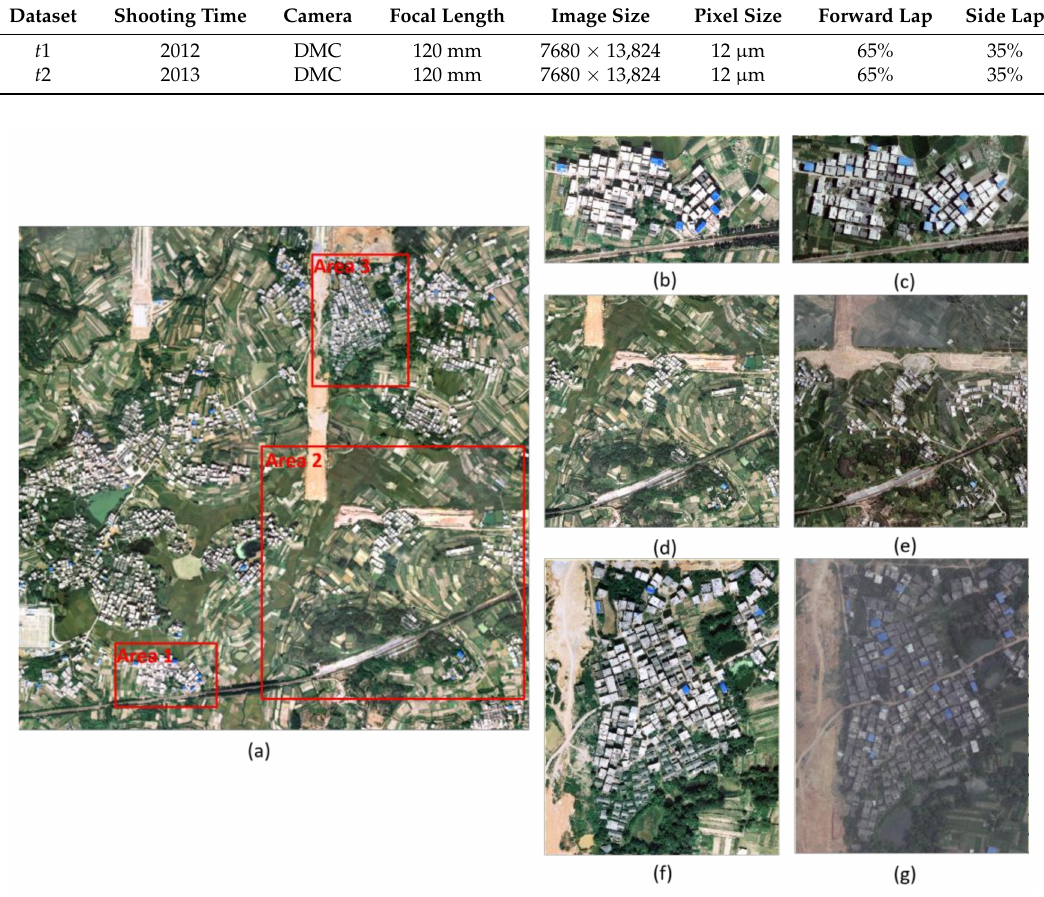
Figure 6. Overview of the large dataset and the three selected datasets. ( a ) Overview of the large dataset; ( b ) test area 1 in 2012; ( c ) test area 1 in 2013; ( d ) test area 2 in 2012; ( e ) test area 2 in 2013; ( f ) test area 3 in 2012; and ( g ) test area 3 in